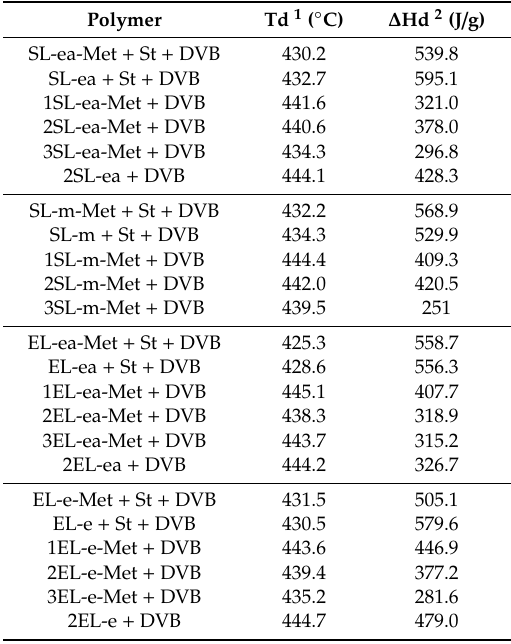
Table 3. DSC data.